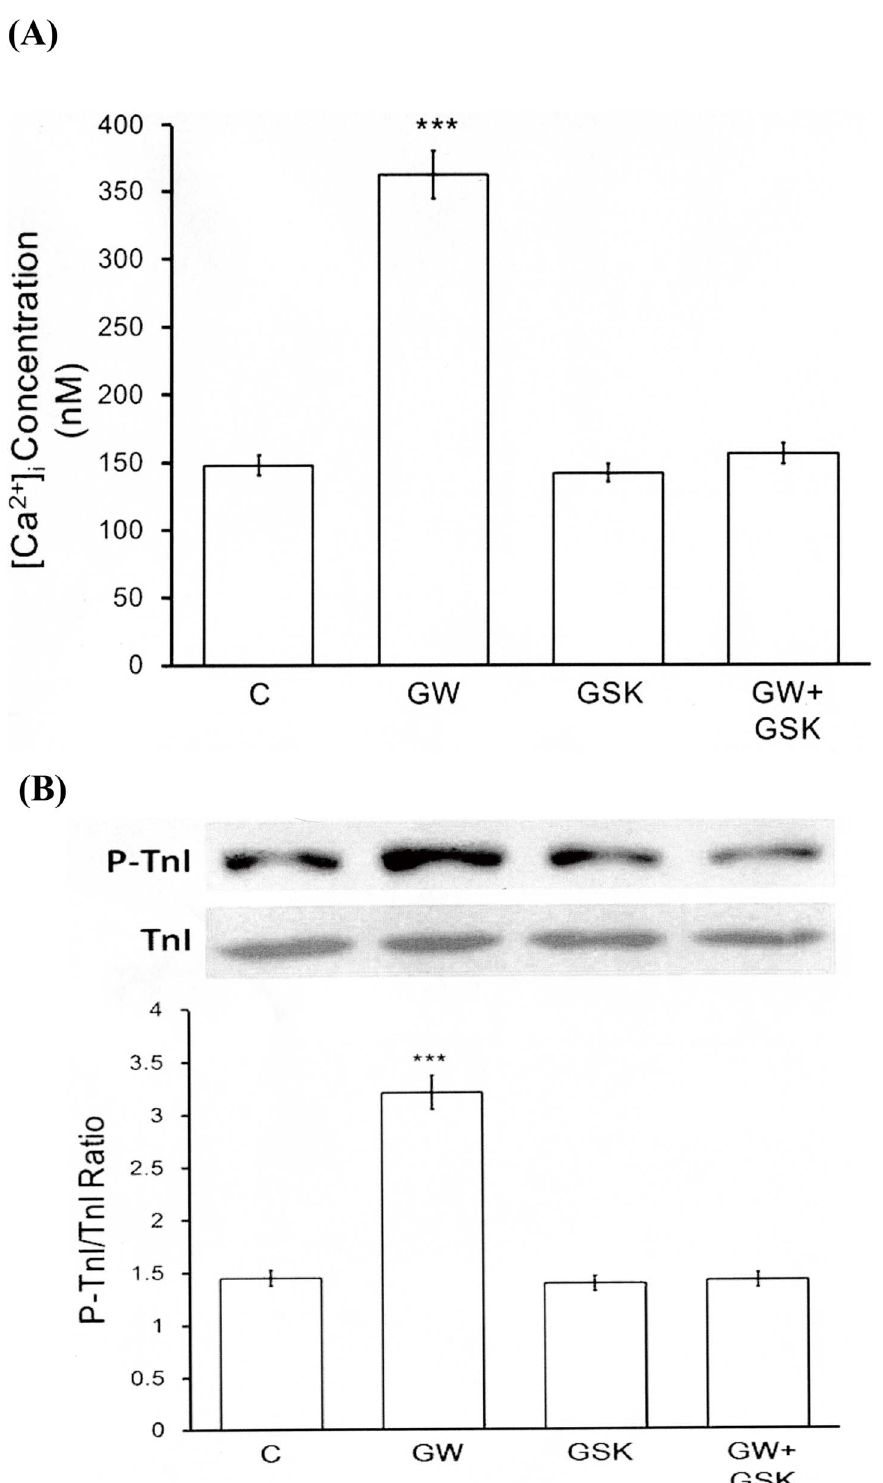
Figure 4. Effects of GW0742 on Intracellular Calcium and TnI Phosphorylation in Neonatal Rat Cardiomyocytes. (A) Changes in intracellular calcium were detected with Fura-2 by using a fluorescence spectrofluorometer. The neonatal rat cardiomyocytes were placed in buffered physiological saline solution with 5 m M of fura-2-AM, and incubated for 1 h. After recording the baseline value, GW0742 was added into the cuvette with/without GSK0660 to detect the free intracellular calcium. (B) Effect of GW0742 on TnI phosphorylation in the neonatal rat cardiomyocytes. Cells were treated with GW0742 for 30 minutes and were then harvested to measure the protein level of TnI phosphorylation by Western blotting analysis. All values are presented as mean 6 SEM (n=8). *** P , 0.001 compared with the control group.